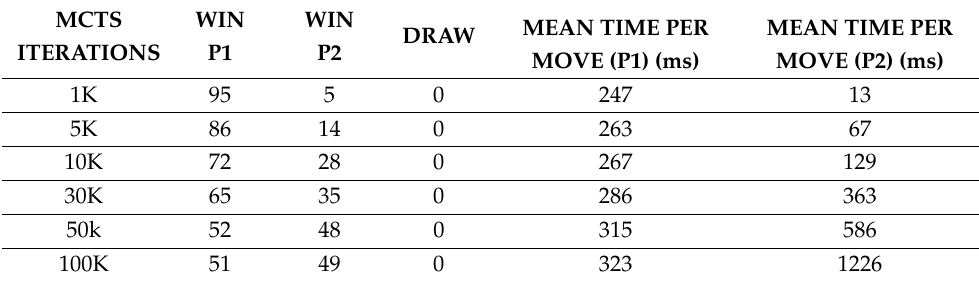
Table 4. Results from starting node State S without ANN